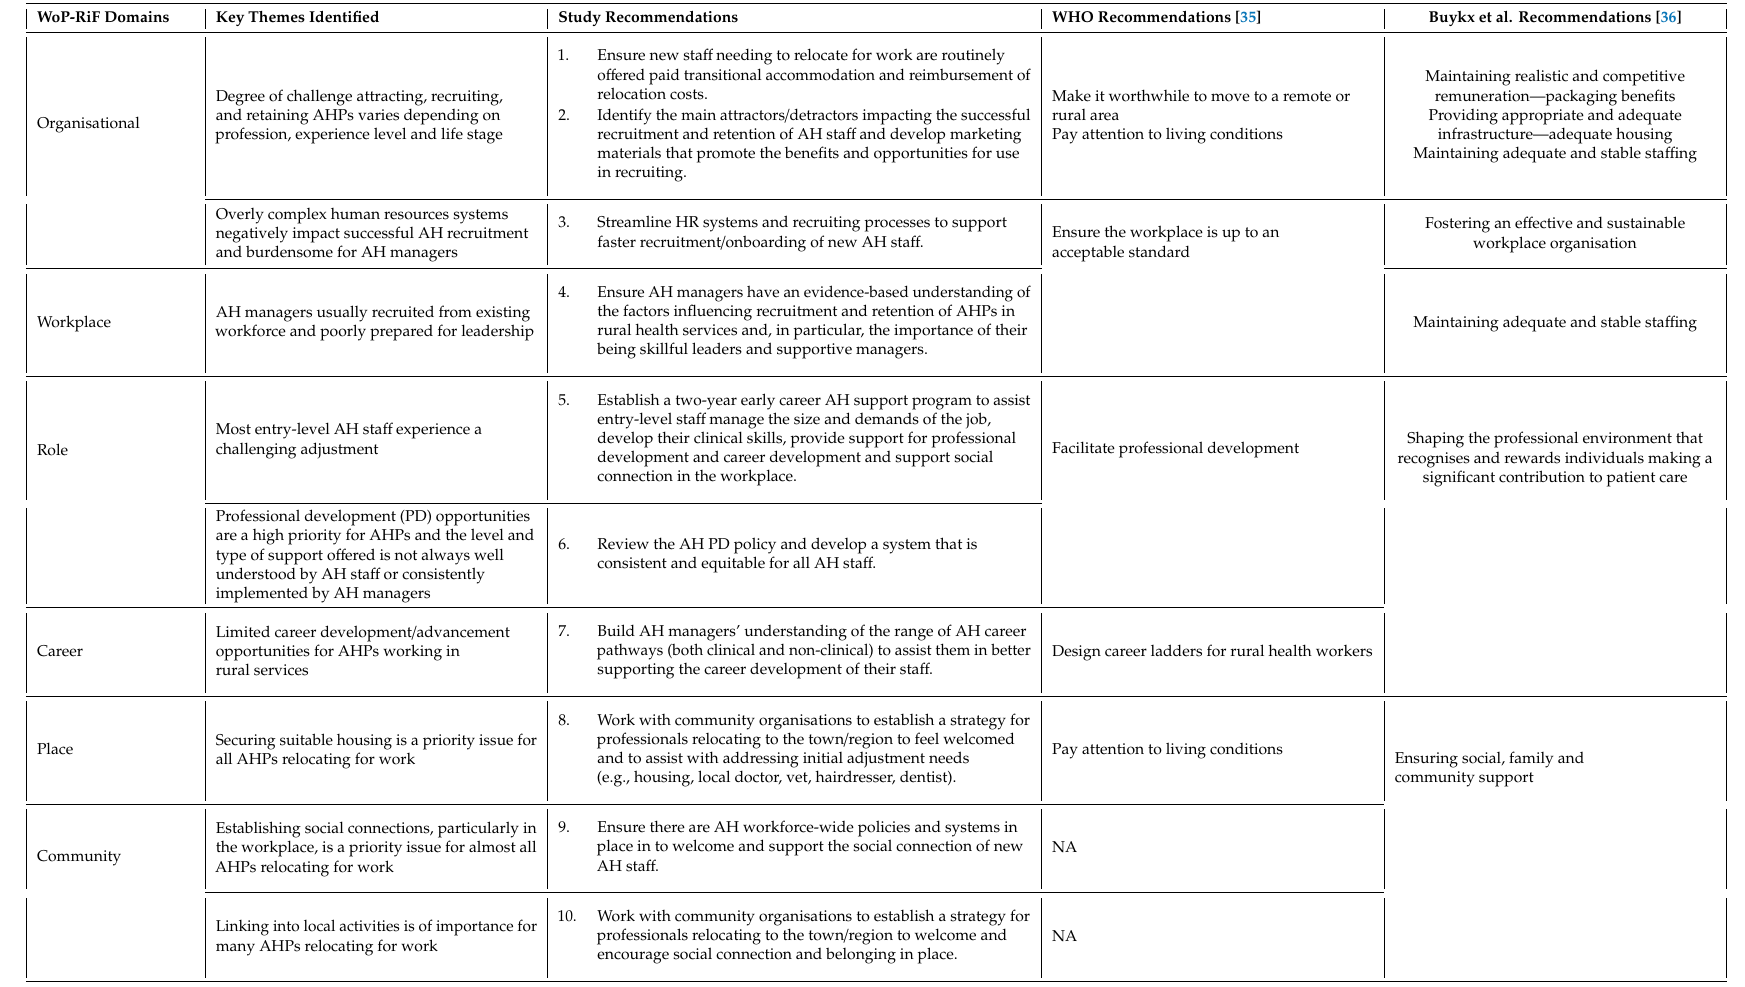
Table 4. Ten common recommendations to improve retention of AH workforce in two rural public sector health services and their correspondence to recommendations made by the WHO and / or Buykx et